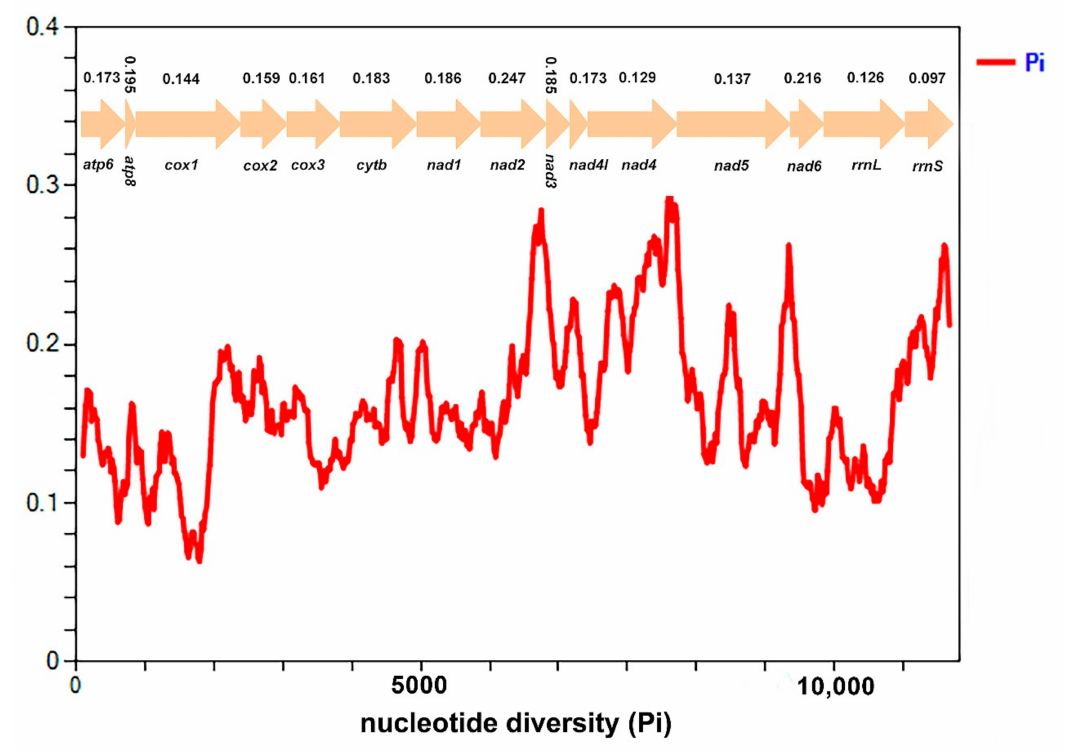
Figure 5. Sliding window analysis of 13 PCGs and 2 rRNAs based on eight Ricaniidae species. The red line shows the value of nucleotide diversity Pi (window size = 200 bp, step size =20 bp). The Pi value for each gene is shown in the graph.